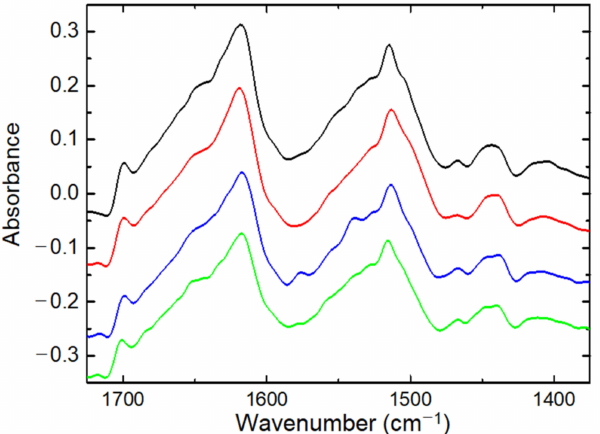
Figure 6. FTIR spectra of silk B. mori samples; from top to bottom: (black) original silk B. mori cocoon (HL = 0.08); (red) silk B. mori cocoon after heating); (blue) silk thread B. mori after tensile loading in water (before measurement, the sample was dried in air to the same HL as it was in untreated silk fibre B. mori , Figure 3); (green) silk fibres B. mori after 7 cycles of tensile loading-release in open air. All measurements were conducted at room